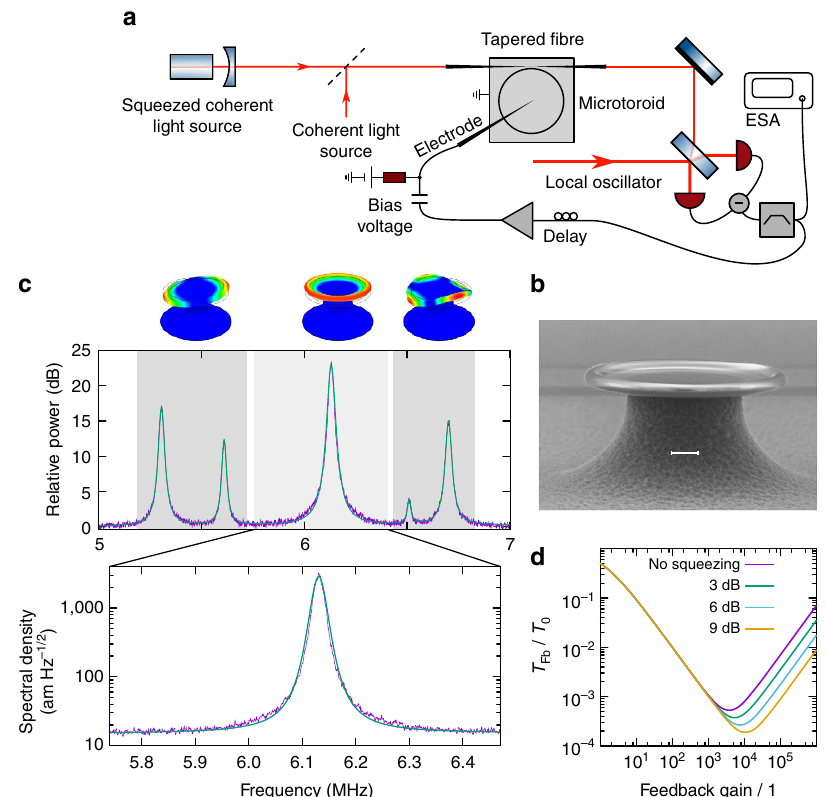
Figure 1 | Experimental and conceptual details. ( a ) Sketch of the experimental setup. The mechanical motion in a microtoroid was sensed using a squeezed or coherent state coupled evanescently to the microtoroid via a tapered fibre. The electrical output of a homodyne detector was bandpass filtered around the mechanical resonance frequency, delayed, amplified and fed back to the mechanical resonator via an electrical actuator. An electrode tip held close above the toroid combined with a grounded base plate formed the actuator. ESA, Electrical Spectrum Analyser. ( b ) Scanning electron microscope picture of the microtoroidal resonator with a radius of 37.5 m m and an optical Q value of 1 (cid:4) 10 6 . The scale bar corresponds to 10 m m. ( c ) Mechanical spectrum of the microtoroid measured with a coherent probe beam of 50 m W (equal to an intra-cavity photon number of N c ¼ 5.1 (cid:4) 10 4 ). From the measurement we infer a cooperativity of C ¼ 5.2 (cid:4) 10 (cid:2) 4 . The range from 5 to 7MHz is magnified to highlight the spectrum as it was detected after the bandpass filter. By means of a finite element method analysis, the mechanical modes had been computed. Each mode corresponds to the resonance shown underneath. The first and the third mode are non-degenerate due to asymmetries in the fabrication. ( d ) Example of the achievable temperature improvement in dependence of the degree of squeezing. For the calculation, we assumed n th ¼ 10 4 , C ¼ 10 3 , unity efficiencies and a coupling efficiency of